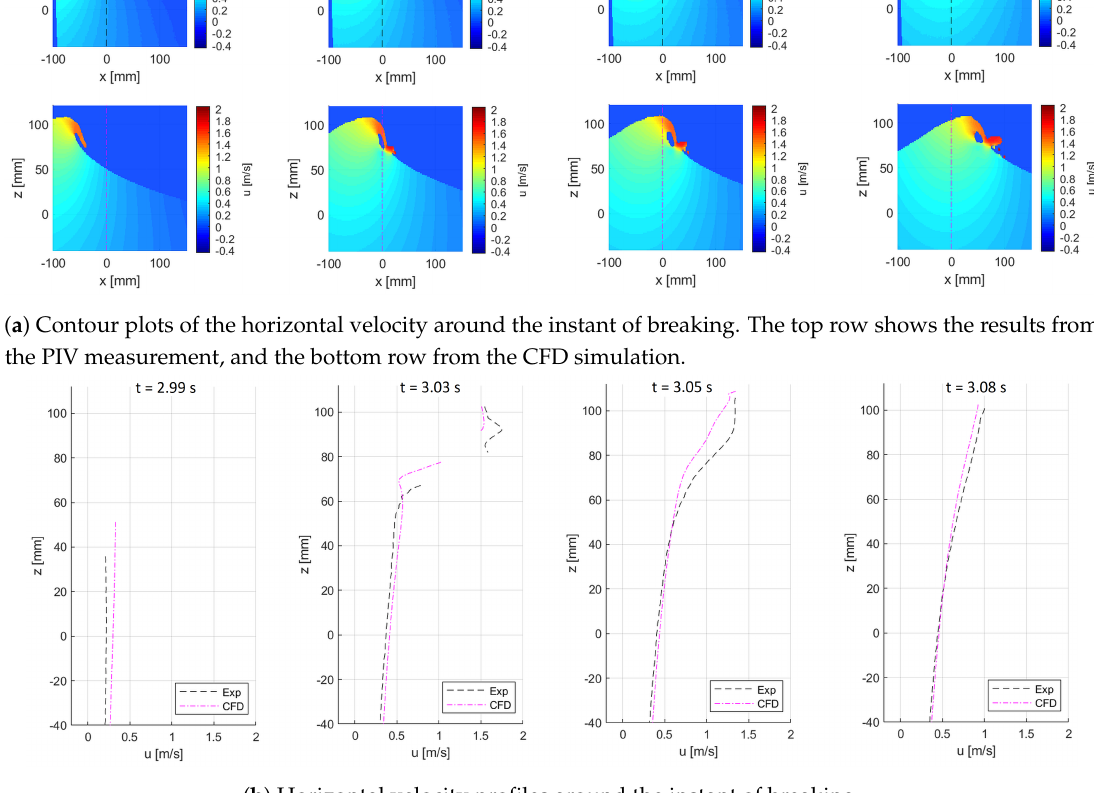
Figure 17. Comparison of the horizontal kinematics for the plunging breaker. From left to right, plots were produced at different instances before and after breaking. Note that contour plots and profile plots are produced at the same instant in time. The velocity profiles were extracted at the x = 0 m location denoted by the dashed line in Figure